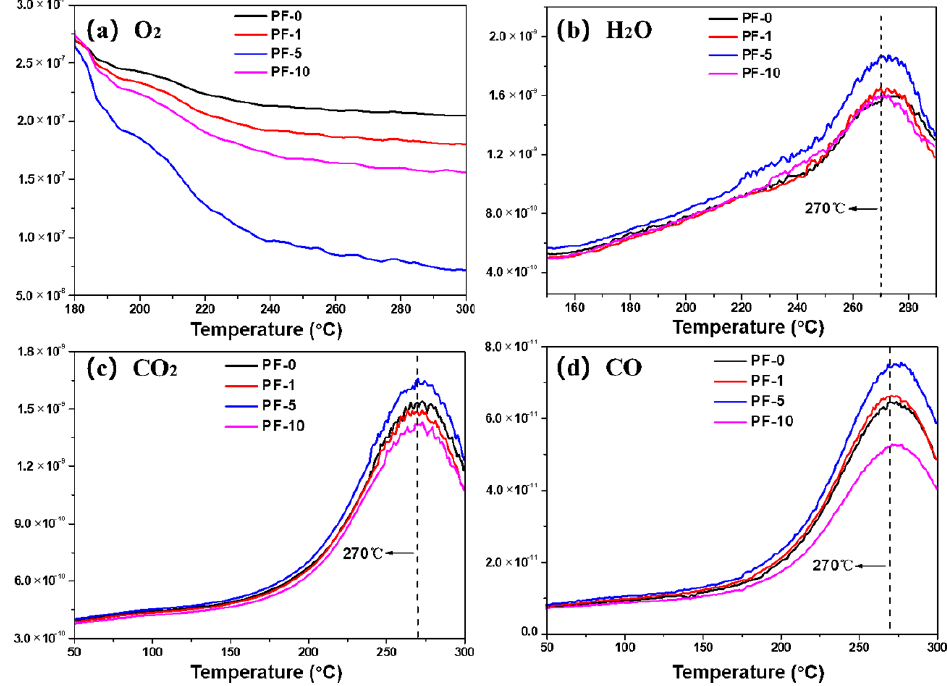
Figure 5. MS curves of different PIM-derived pitch fibers in air: ( a ) O 2 ; ( b ) H 2 O; ( c ) CO 2 ; ( d ) CO.